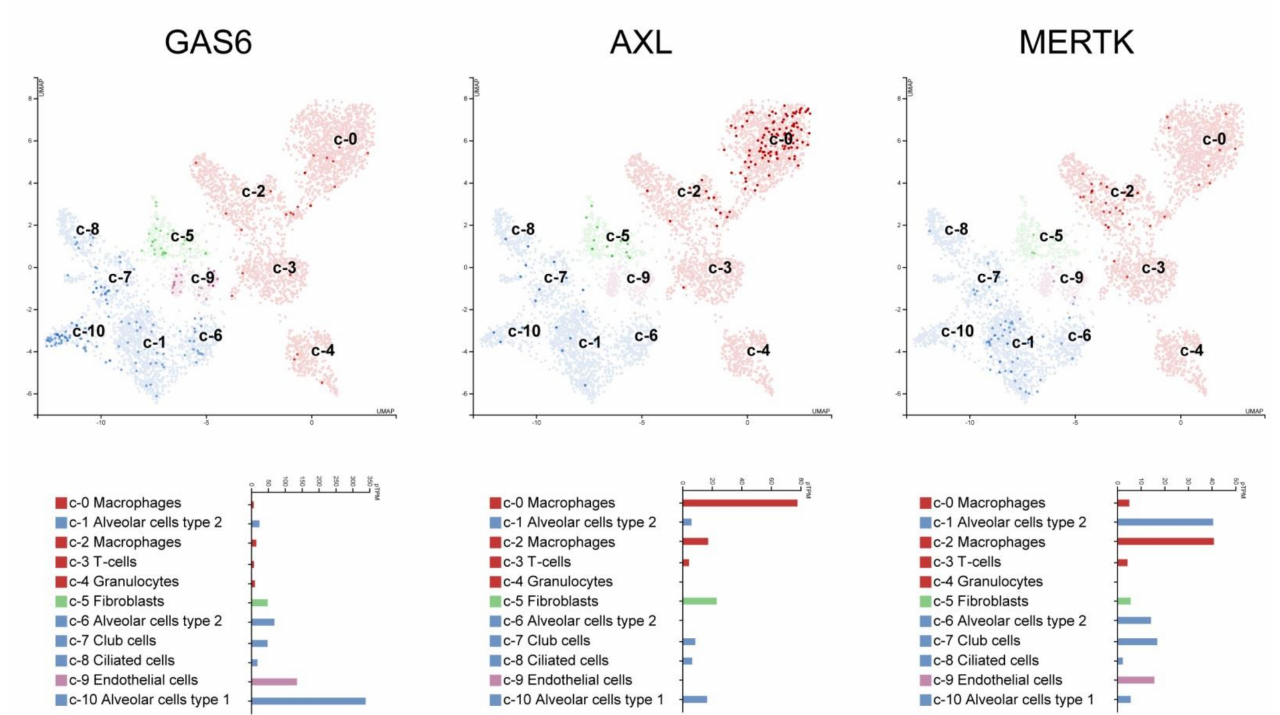
Figure 4. GAS6, AXL, and MERTK mRNA expression in human lung cells. Individual cells in each cluster are visualized with color intensity according to the specific mRNA expression; where each dot corresponds to a cell. Mean mRNA expression on each individual cell type is indicated below. Data are derived from http://www.proteinatlas.org.